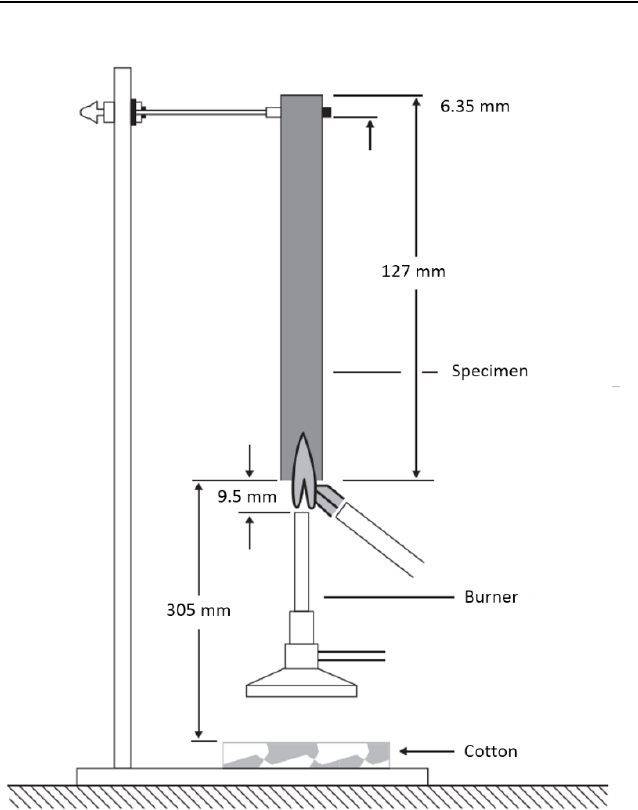
Figure 14. UL 94 vertical testing apparatus. Reprinted with permission from Ref. [72]. Copyright 2009, Elsevier.